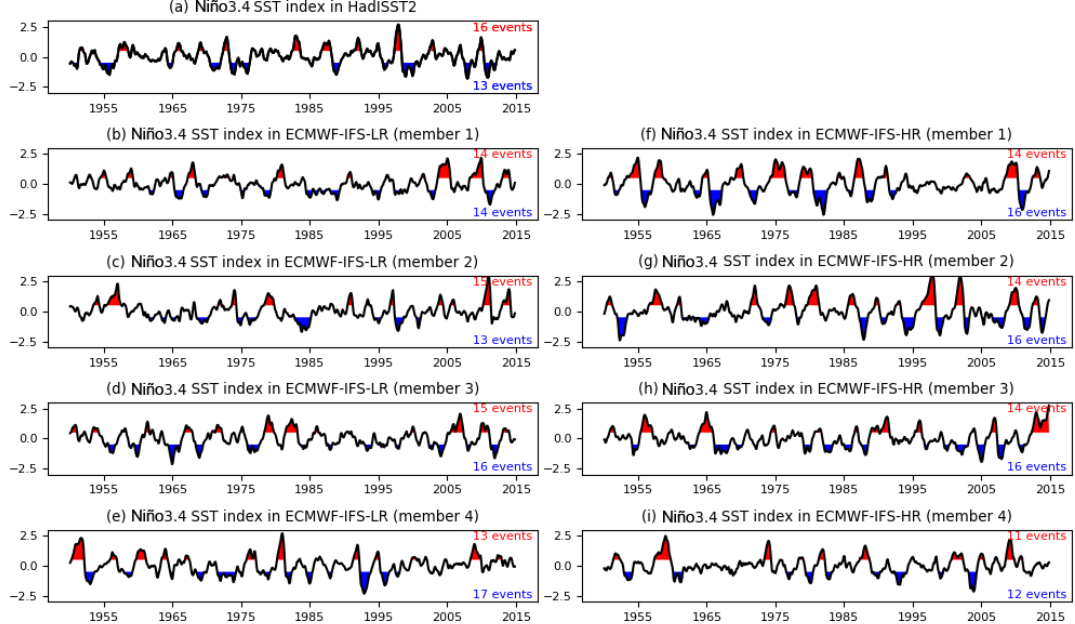
Figure 15. Detrended 3-month running mean SST anomalies (K) relative to 1981–2010 in the Niño3.4 region (120–170 ◦ W and 5 ◦ S–5 ◦ N) from (a) HadISST2, (b–e) four members of hist-1950 from ECMWF-IFS-LR, and (f–i) four members of hist-1950 from ECMWF-IFS-HR. Highlighted El Niño/La Niña events correspond to periods with five consecutive and overlapping 3-month means with SST anomalies above 0.5K/below − 0 . 5K.